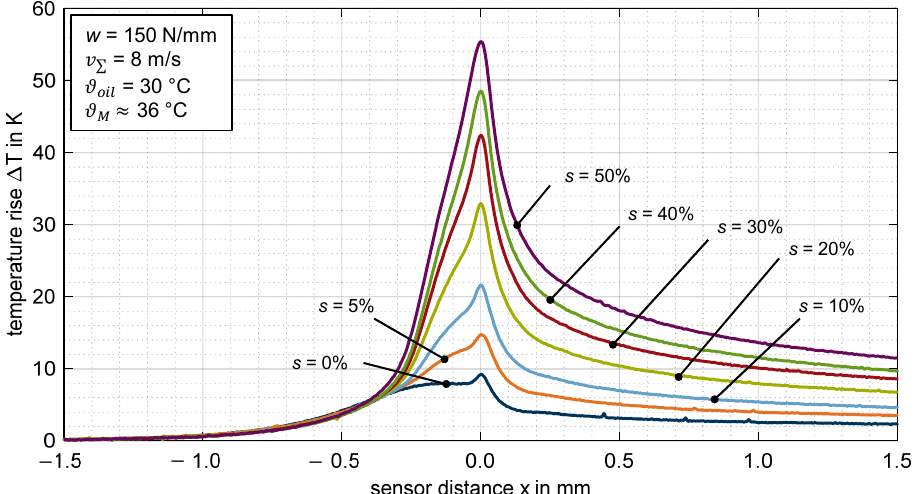
Figure 12. Temperature rise ∆ T for different slip ratios where s = {0; 5; 10; 20; 30; 40; 50}% for the steel EHL contact ZrO 2 /steel (line load w = 150 N/mm, sum velocity v ∑ = 8 m/s, oil temperature ϑ oil = 30 ◦ C, MIN100).